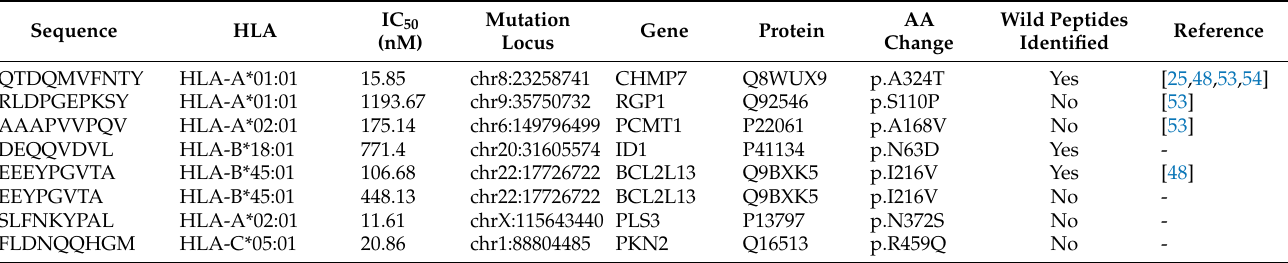
Table 1. List of mutant peptides identified in HCT116